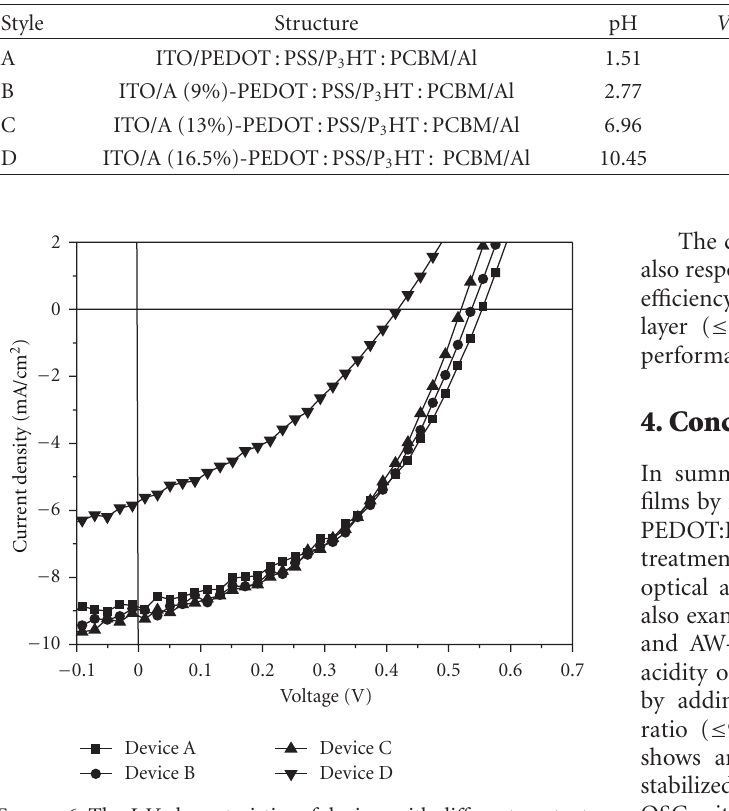
Figure 6: The I-V characteristics of devices with di ff erent contents of AW. Device A: pristine PEDOT:PSS film; Device B: A (9%, v/v)- PEDOT:PSS film. device C: A (13%, v/v)-PEDOT: PSS film; device D: A (16.5%, v/v)-PEDOT:PSS